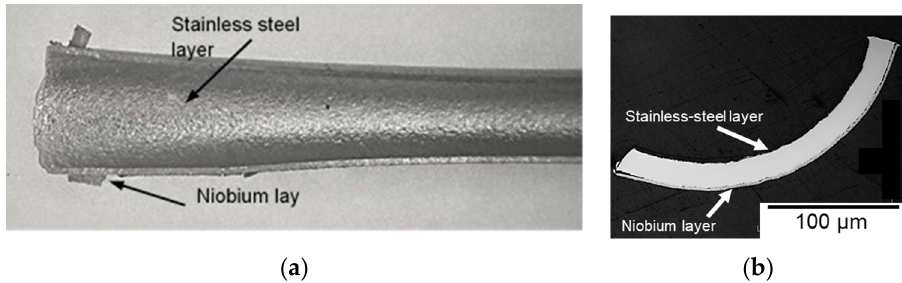
Figure 9. Warping under tensile loading of niobium clad stainless-steel specimen as indicated by ( a ) the canoe-like profile in the optical image of the specimen, and ( b ) the convex curvature in the optical micrograph of the cross-section along the specimen width.